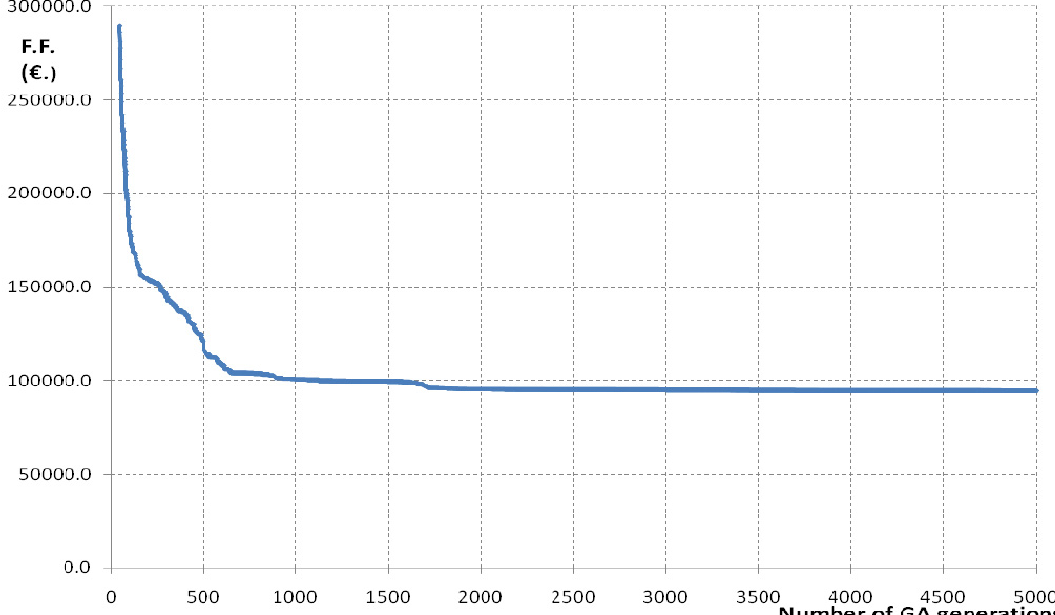
Figure 5. The behavior of fitness function for the case